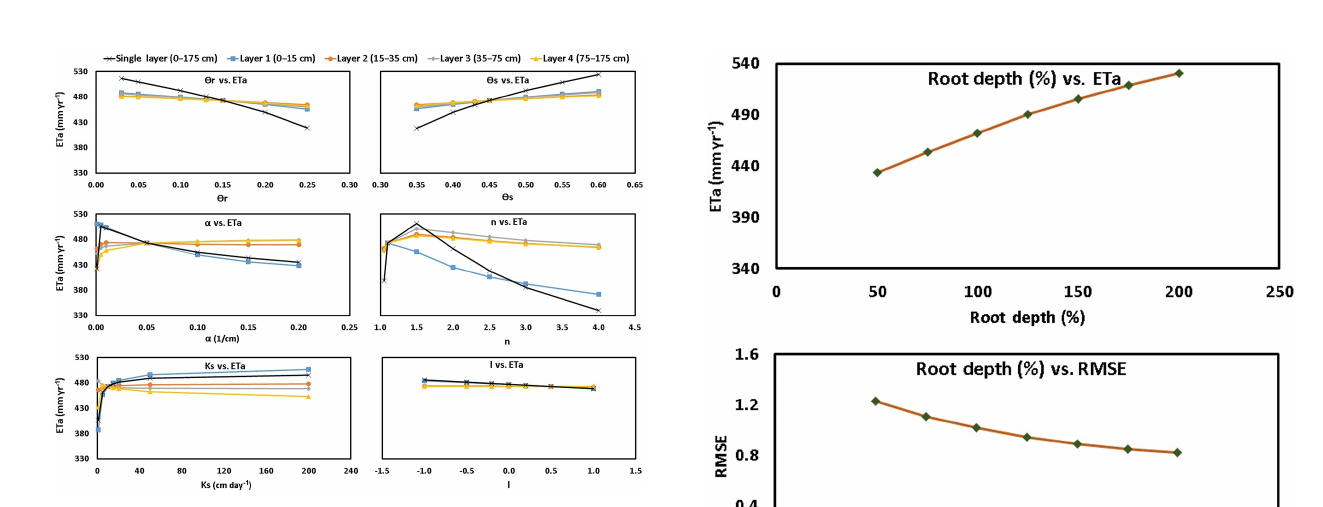
Figure 10. Sensitivity analysis of the effect of soil hydraulic param- eters on average annual ET a values (2007–2012) for a single homo- geneous soil layer (6 parameters) and for a four-layer soil profile (24 parameters).